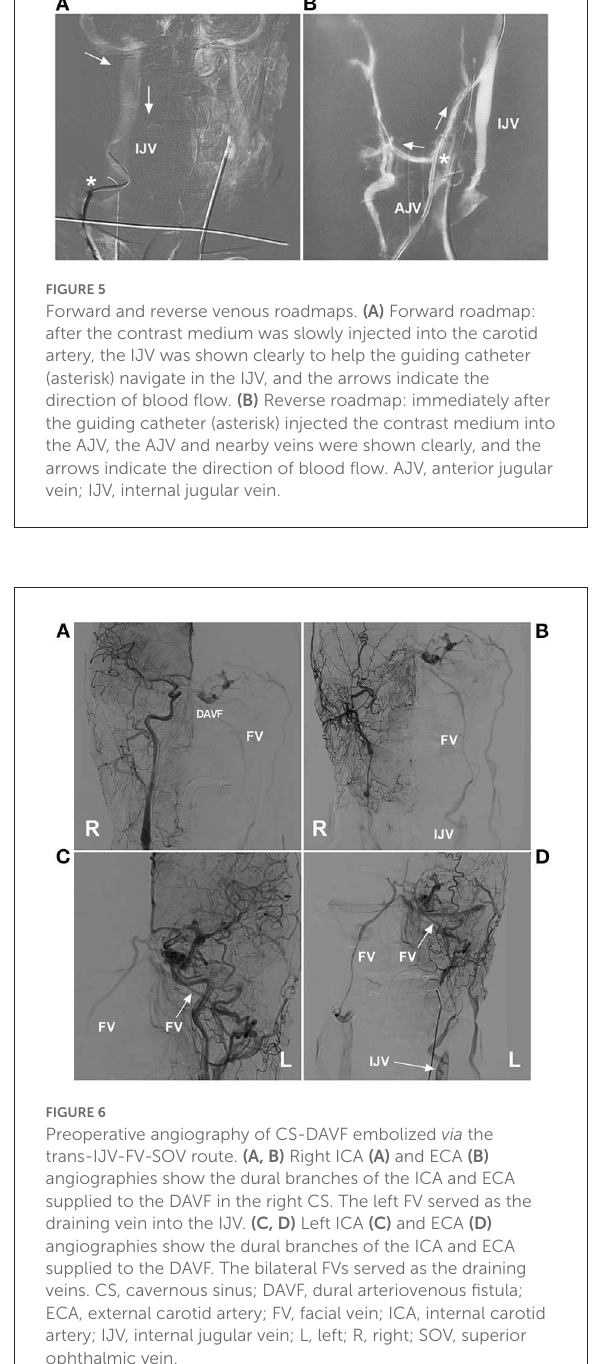
retrograde catheterization of a microcatheter is performed through the FV, the angular vein, the SOV, and then into the CS under the assistance of forward and reverse venous roadmaps (39).